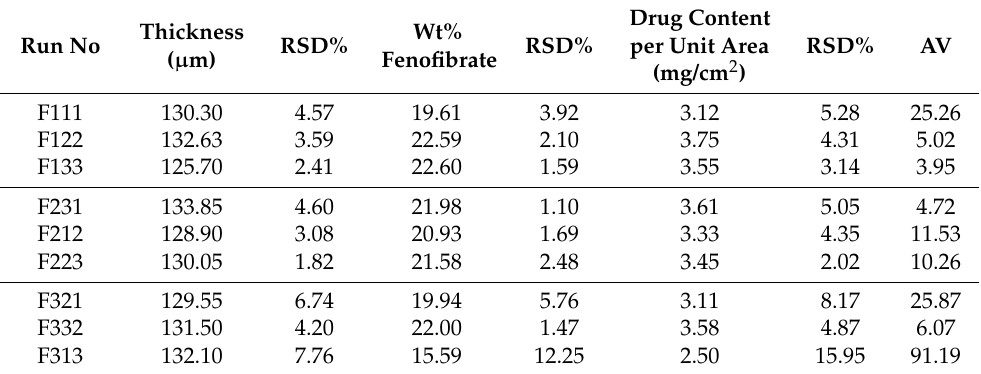
Table 3. Average values and RSD% of dried-film thickness, drug concentration (wt%), drug content per unit area along with acceptance values (AV) for the